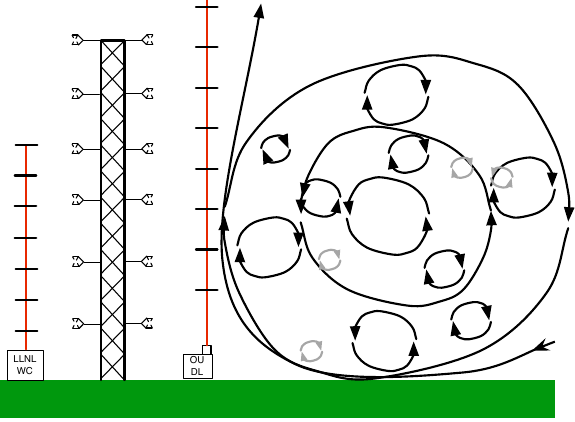
Figure 1. Diagram showing various scales of turbulence compared to the resolution volumes of the DLs and sonic anemometers on the tower. DL beams are denoted by red lines and range gates by black line segments over it. The DL is able to resolve many of the larger turbulent eddies, but vertical velocities associated with eddies smaller than the range-gate size, such as those shown in grey, cannot be resolved. Many of the smaller eddies may be captured by the sonic anemometer, since their resolution volume is much smaller than the DL. Image is not to